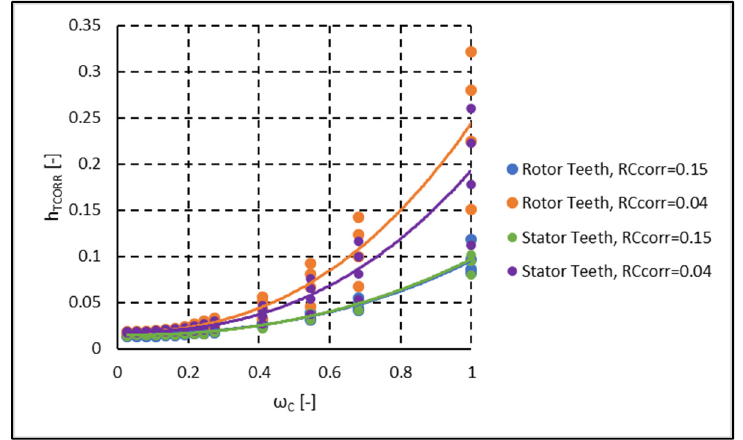
Figure 12. Flow coefficient trendlines.